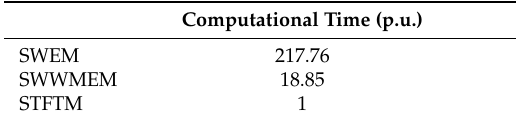
Table 4. Case study 2: Computational times in per unit of computational time required by STFTM. Computational Time (p.u.)